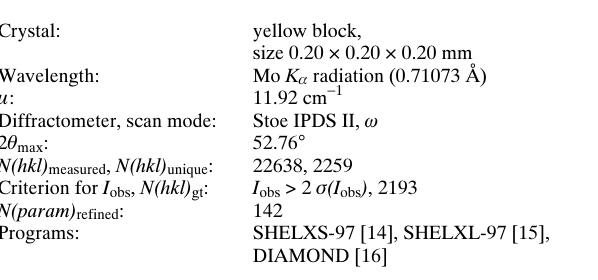
Table 1. Datacollection and